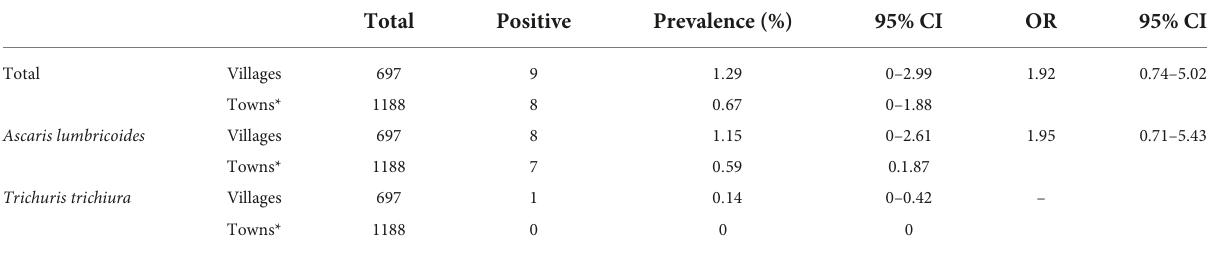
TABLE 2B Soil-transmitted helminths (STH) prevalence in the non-Roma population of Eastern Slovakia (Košice and Prešov regions) categorized by residency